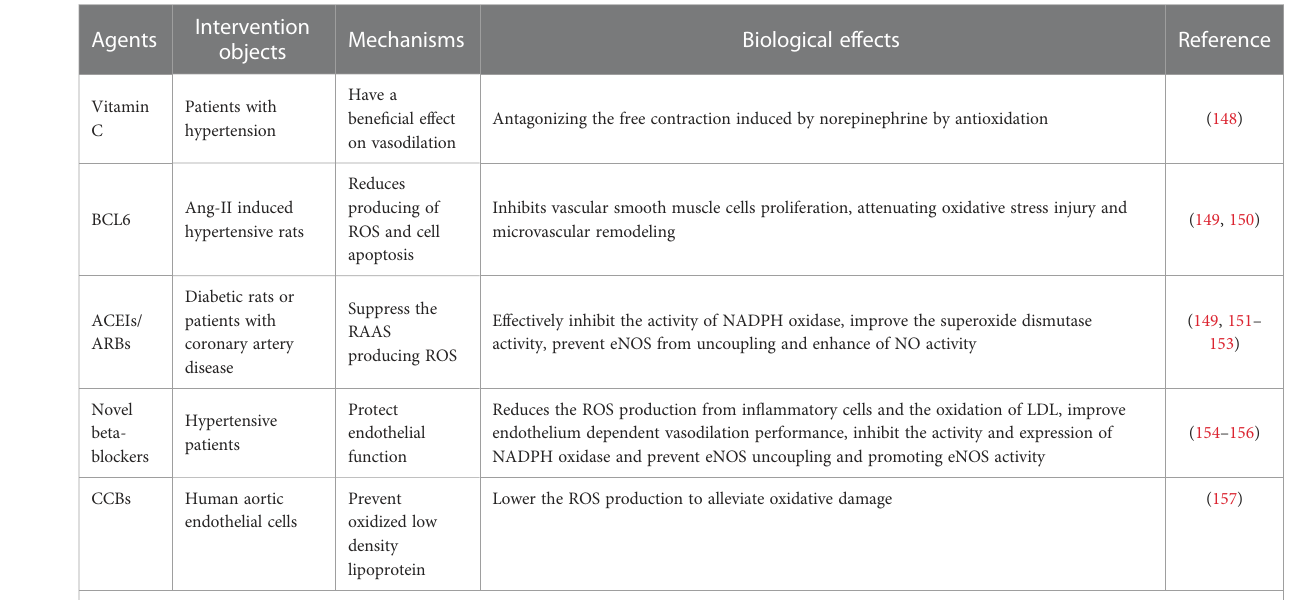
TABLE 3 Antioxidant therapy in